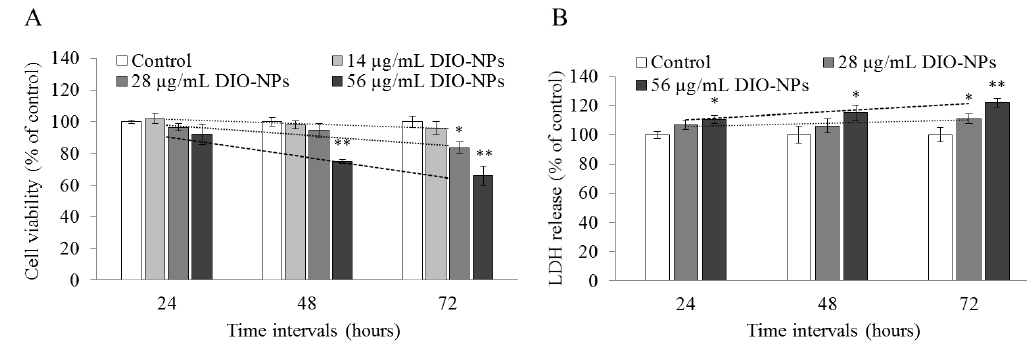
Figure 5. Effects of different concentrations of DIO-NPs on Jurkat cell viability ( A ) and membrane integrity ( B ) after 24 h, 48 h, and 72 h. Values were calculated as percentage of treated cells compared to the control and expressed as means ± SD ( n = 3/experimental group). * p < 0.05 vs. control; ** p < 0.01 vs. control.